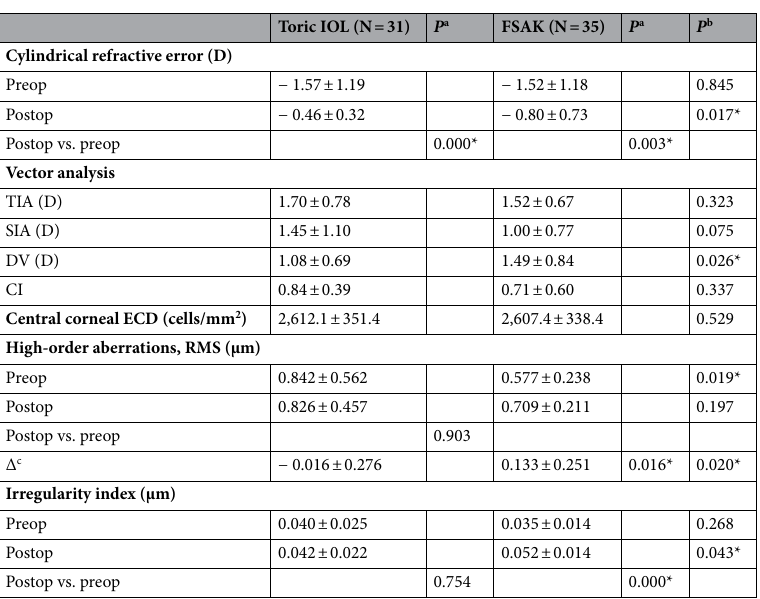
Figure 2. Preoperative and postoperative refractive astigmatism in the toric IOL group ( left ) and FSAK group ( right ) ( IOL intraocular lens, FSAK femtosecond laser-assisted astigmatic keratotomy).